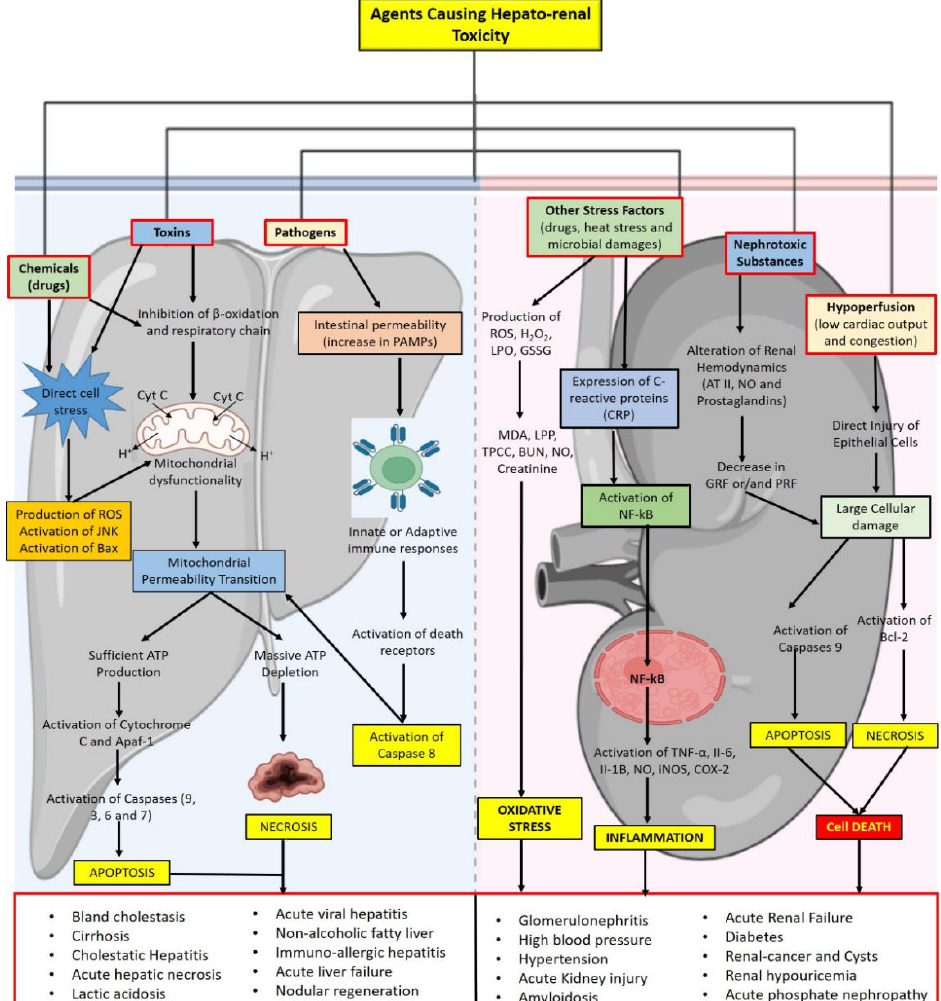
Figure 1. A phenomenological model of hepato-renal toxicity.